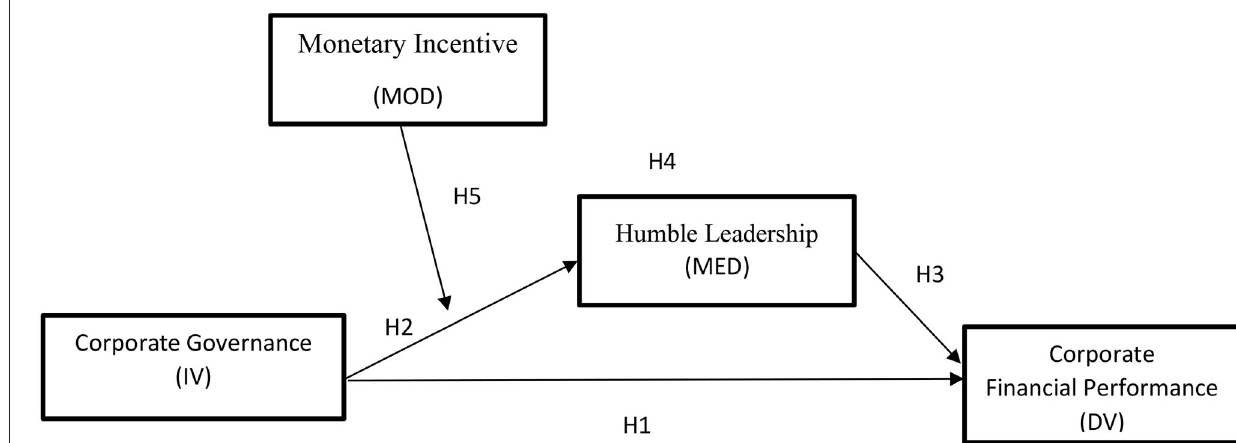
FIGURE 1 | Conceptual model.